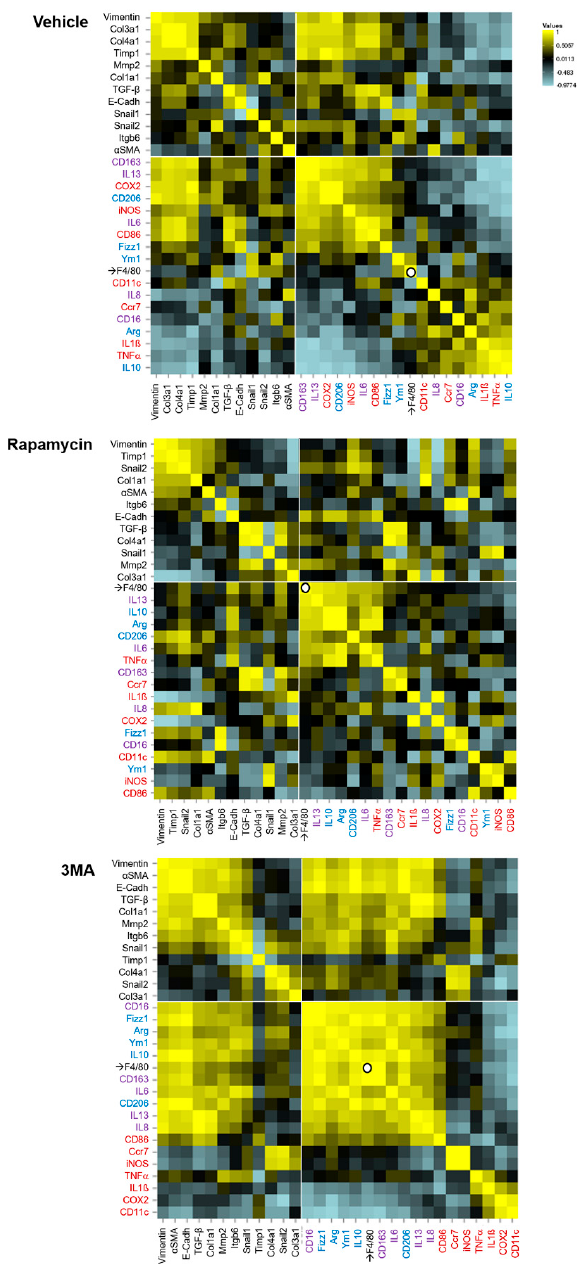
Figure 2. Correlation matrixes representing the Pearson’s correlation coefficient between pairs of data on mRNA expression in intestinal explants. Murine intestinal fibrosis was induced by the heterotopic transplant of colonic tissue in mice receiving a daily intraperitoneal injection of the autophagy stimulator rapamycin (1.25 mg / kg mice), the autophagy inhibitor 3-methyladenine (3-MA, 10 mg / kg mice) or their vehicle (DMSO 1%, n = 5 each). The intestinal grafts resected seven days after transplantation were analyzed with regard to their mRNA expression of genes involved in (i) fibrosis and epithelial to mesenchymal transition; and (ii) inflammation: the general macrophage marker (F4 / 80), pro-inflammatory (red), anti-inflammatory (blue) and pro-fibrotic (purple) molecules. The data were organized taking as references: (i) the fibroblast marker vimentin (in all groups); and (ii) the macrophage marker which correlates with a higher number of markers of inflammation in each experimental group (vehicle: CD163; rapamycin: F4 / 80, 3-MA: CD16). The pairwise comparison heatmaps were performed using the online resource available at http: // www.heatmapper.ca, and interpreted according to its authors’ instructions